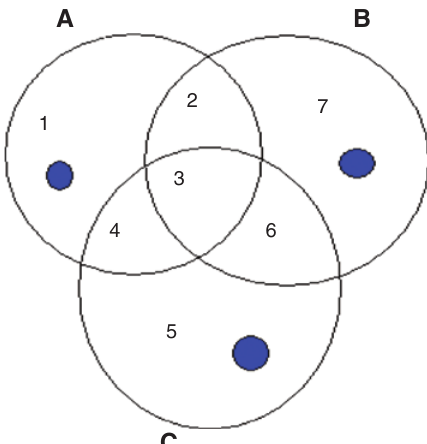
Figure 2: Region of